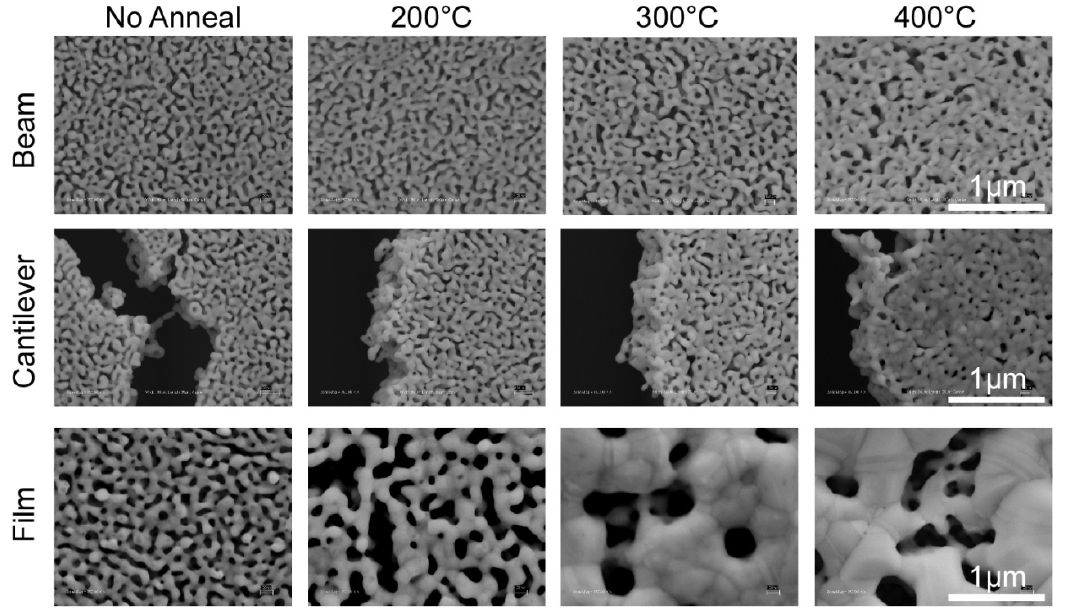
Figure 6. Scanning electron micrographs of np-Au structures under different mechanical constraints. [Reproduced with permission from Acta Mater . 2007 , 55 , 4593–4602. © 2007,